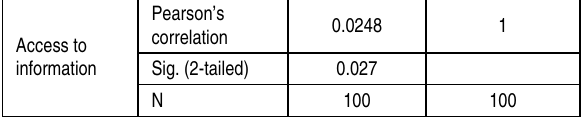
Table 5. Age versus access to technology Age of partici-